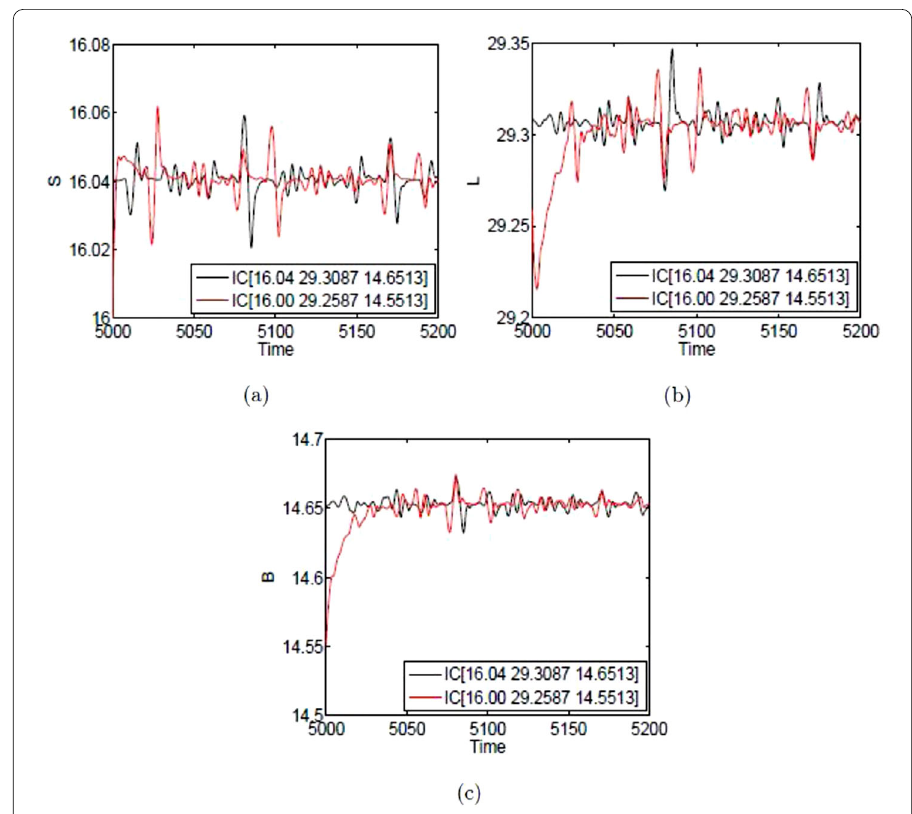
Figure 6 Time series and SIC test of all three classes without delay. The values of other parameters are as in (31)